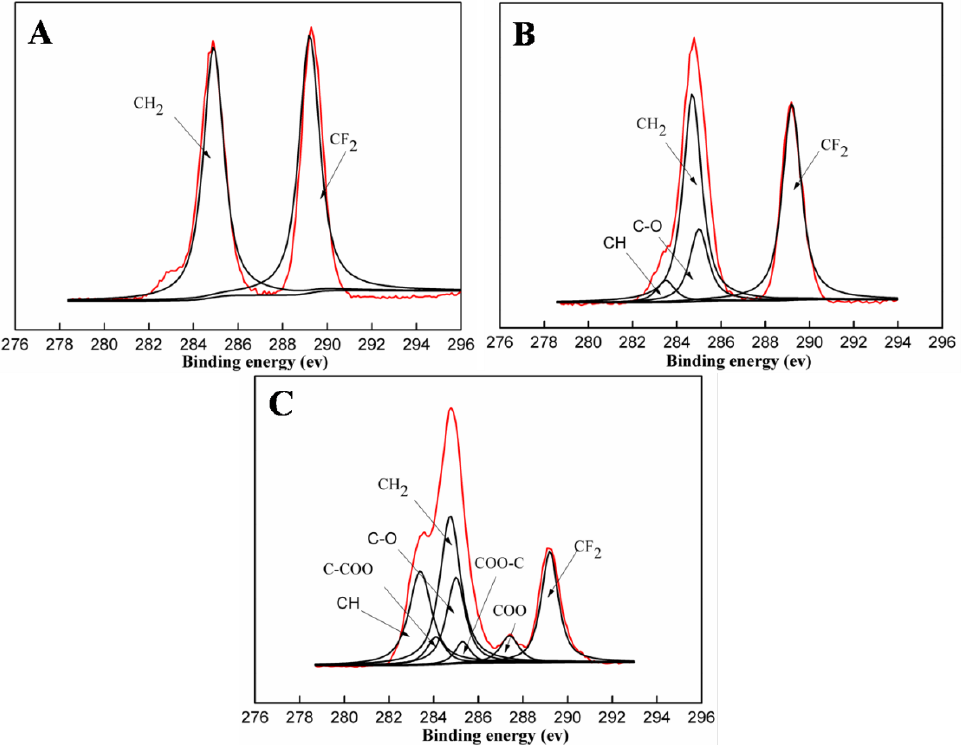
Figure 5. The C1s core level spectra of membranes after heating treatment: ( A ) PVDF, ( B ) PVDF-F127 and ( C ) PVDF-F127-P (MMA-AA).